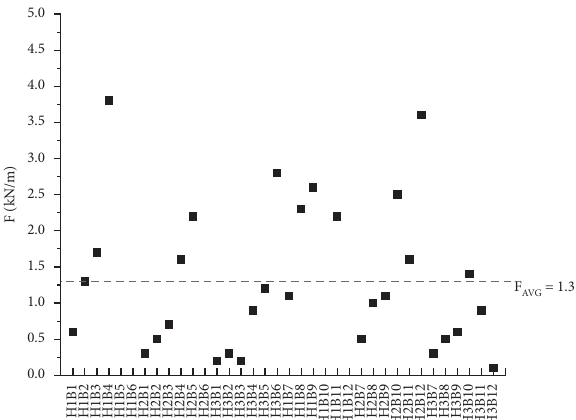
Figure 11: Element model loads under the displacement limit of H / 120.